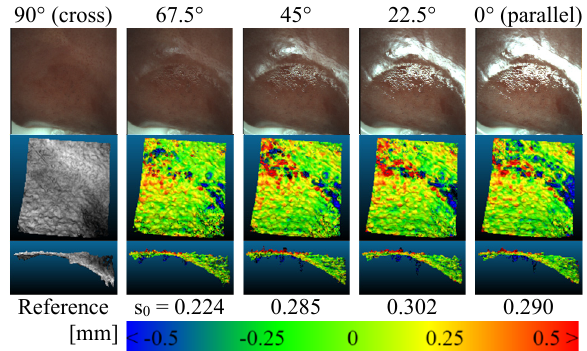
Figure 11. Comparison of different angles of polarisation. Top: original left image; middle: point cloud top view; bottom: point cloud side view; 90°: reference in greyscale; other angles: 3D deviations w.r.t. 90° in colour-code.